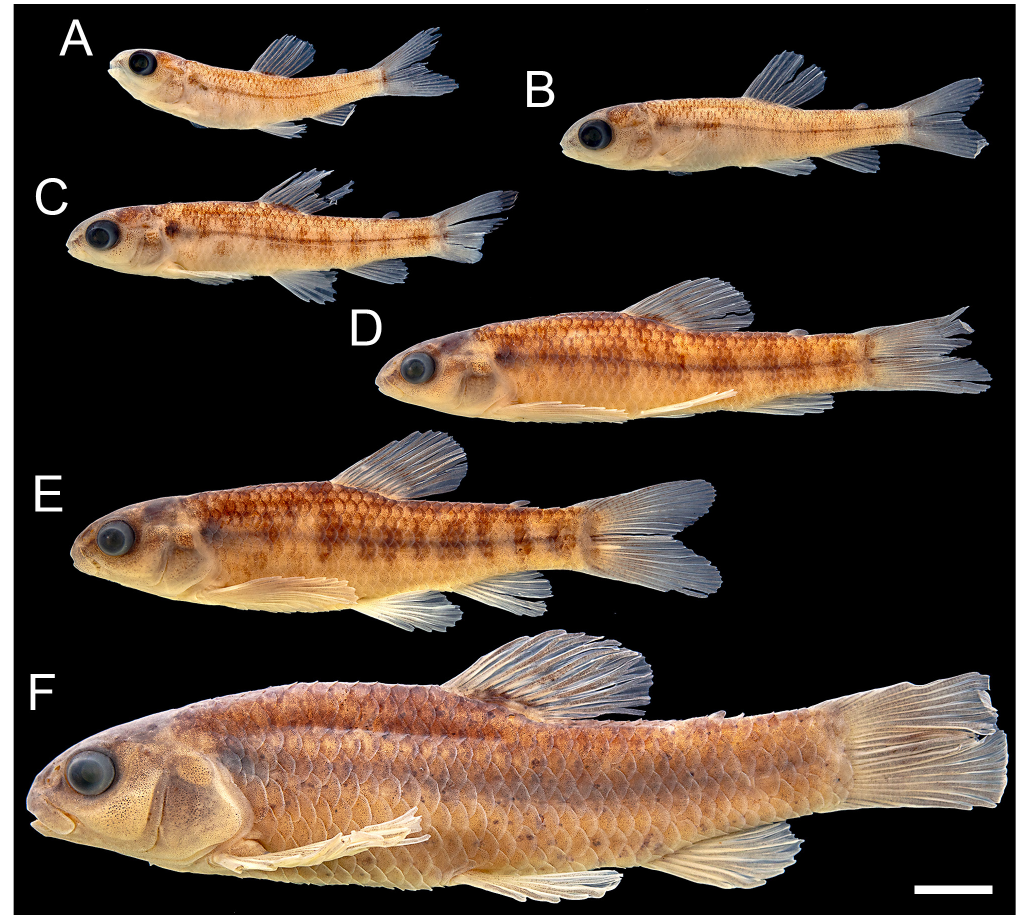
FIGURE 2 | Paratypes of Characidium kalunga , MZUSP 114054, A . 15.3 mm SL, B . 18.2 mm SL, C . 21.4 mm SL, D . 29.7 mm SP, E . 30.9 mm SL, and F . 48.7 mm SL. Scale bar = 5 mm, Chapada dos Veadeiros, Goiás,